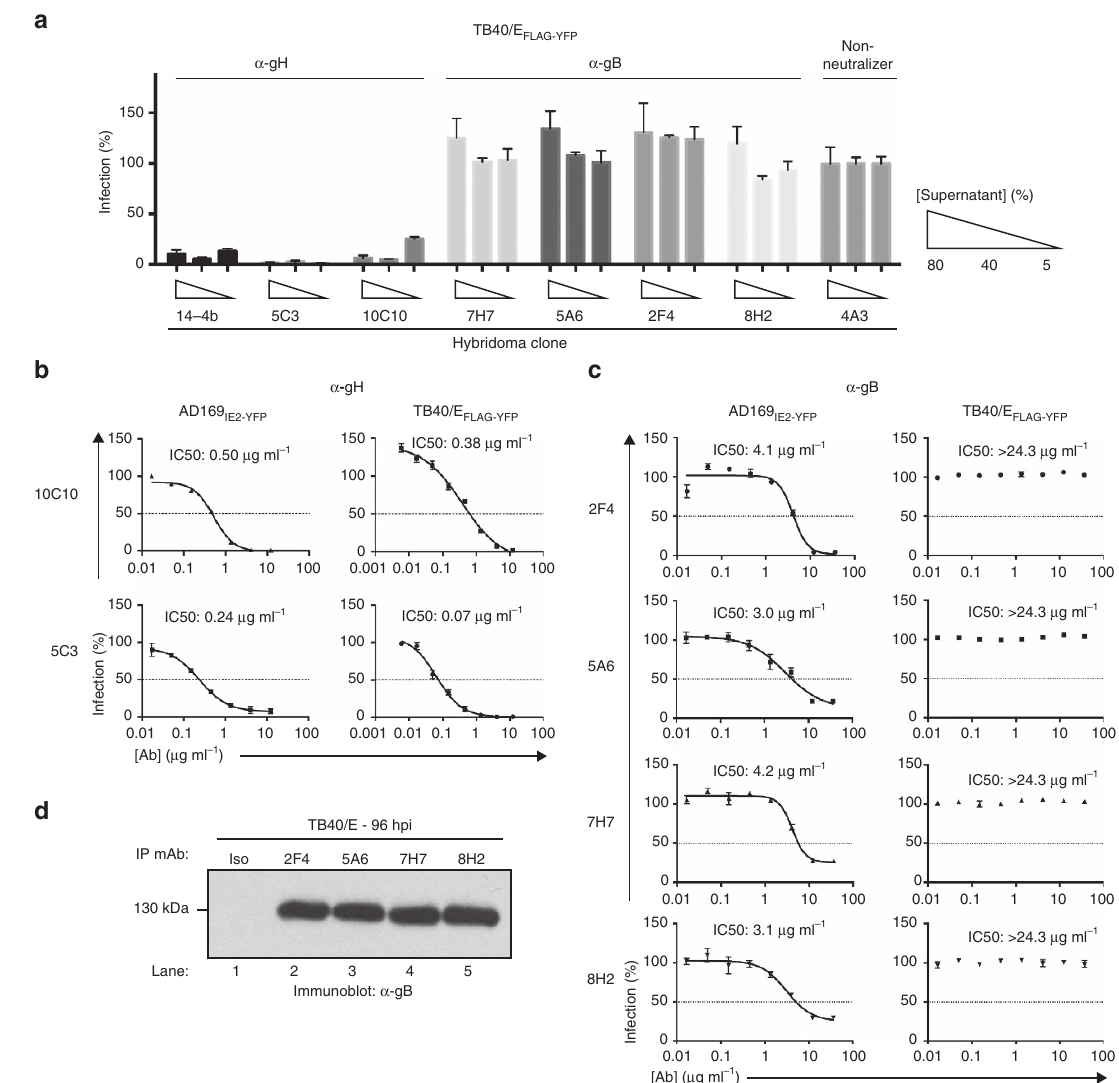
Figure 3 | Examination of the neutralizing capacity of anti-CMV mAbs. ( a ) Hybridoma supernatant from the 6 CMV-neutralizing mAbs was tested at 3 concentrations (5, 40 and 80%) for their ability to inhibit TB40/E FLAG-YFP infection of MRC5 cells. Supernatant from the neutralizing anti-gH mAb 14-4b and supernatant from the non-neutralizing hybridoma clone 4A3 were utilized as controls. Experiments were performed in technical triplicates and s.d. is depicted. ( b ) Anti-gH mAbs 10C10 and 5C3 were pre-incubated with AD169 IE2-YFP (left panel) and TB40/E FLAG-YFP (right panel) at 8 concentrations (0.01–12 m gml (cid:2) 1 ) and infection levels of MRC5 cells was subsequently measured. ( c ) Anti-gB mAbs 2F4, 5A6, 7H7 and 8H2 were pre-incubated with AD169 IE2-YFP (left panel) and TB40/E FLAG-YFP (right panel) at 8 concentrations (0.01–12 m gml (cid:2) 1 ) and infection levels of MRC5 cells was subsequently measured. Non-linear regression analysis was performed and the half maximal inhibitory concentration (IC50) was calculated for all antibodies. ( d ) MRC5 cells infected with TB40/E were harvested at 96 hpi and total cell lysates were exposed to the anti-gB antibodies. Recovered immune complexes were resolved by SDS–PAGE and exposed to anti-gB immunoblot (lanes 1–5). Relative molecular mass markers are indicated. Experiments for ( a – c ) were performed in technical triplicate and s.d. is depicted. Respective virus neutralization experiments were replicated four times each.